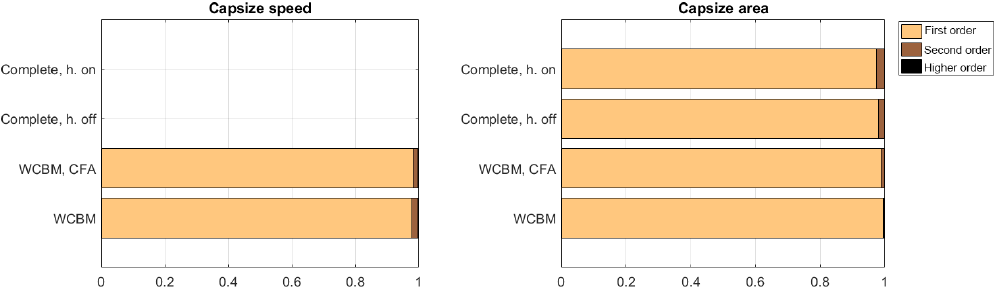
Figure 7. Sensitivity of the capsize mode to first, second, and higher orders of interaction. Models of increasing complexity from bottom to